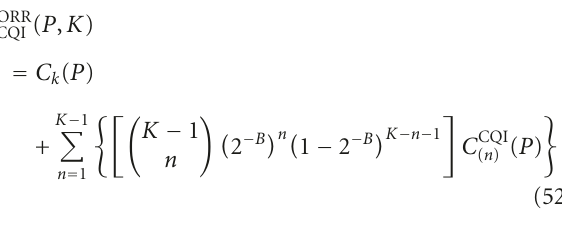
(51) (dashed curves) along with its corresponding asymp- totic upper bounds (dash-dotted lines). The achievable rate for TDMA-RR is also included in these plots (solid lines). To make a fair comparison, Tx power in case of TDMA-RR is equal to the power per beam in case of pure ORR